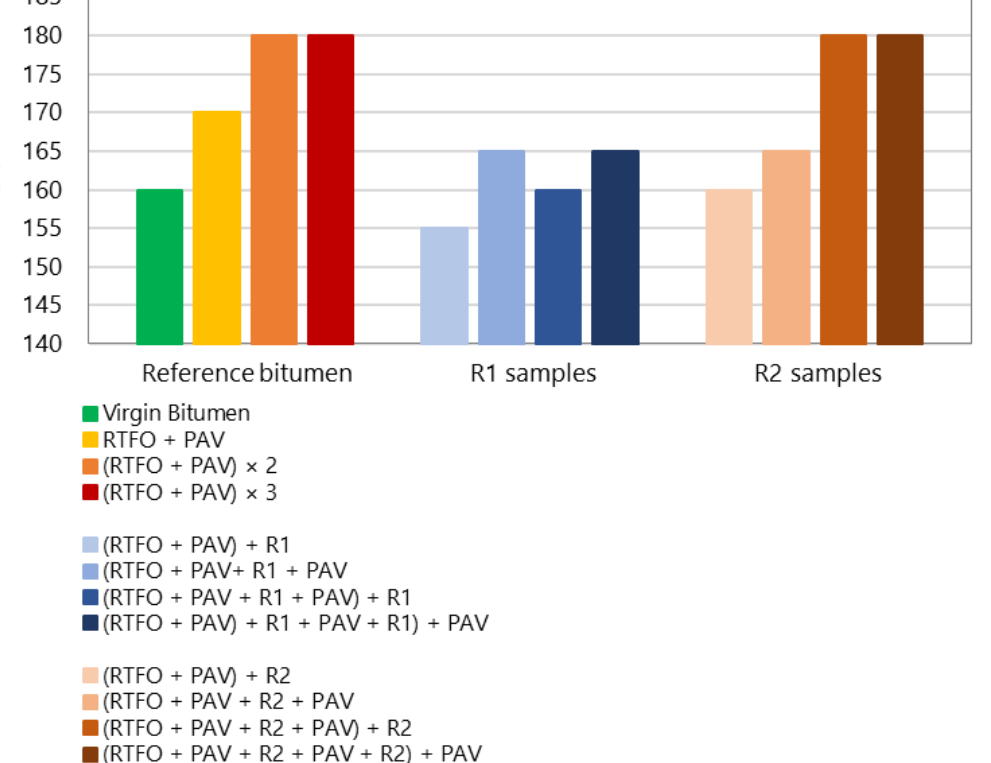
Figure 8. Melting point values of the asphaltenes extracted from each sample.